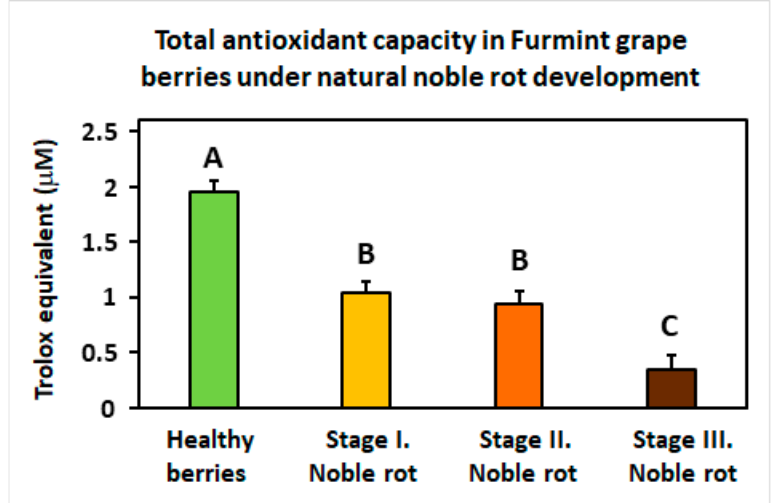
Figure 8. The total antioxidative capacity of grapevine berries at four different stages (Healthy, Stages I.–III. of Noble rot) of botrytization. The antioxidative capacity is expressed in Trolox equivalents. Values are means ± SEM, n = 5 for all groups. Different letters indicate statistically significant differences at p ≤ 0.01.